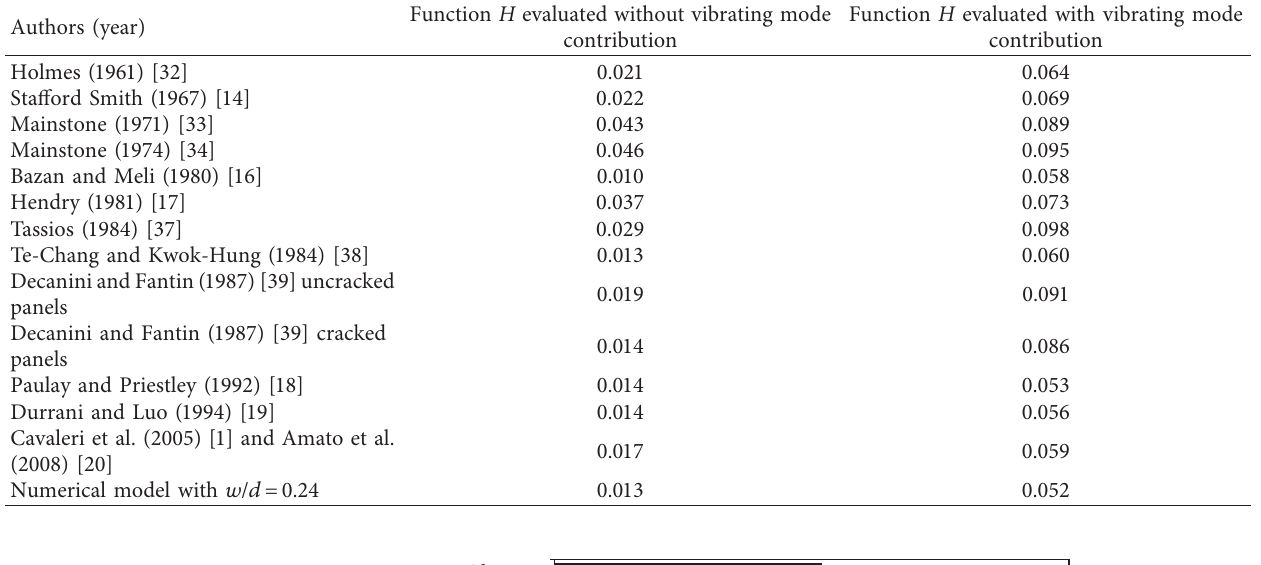
Table 10: Values assumed by the target function H for models with equivalent struts defined using literature proposals and comparison with results obtained from the numerical model with a constant value of w / d ratio equal to 0.24.